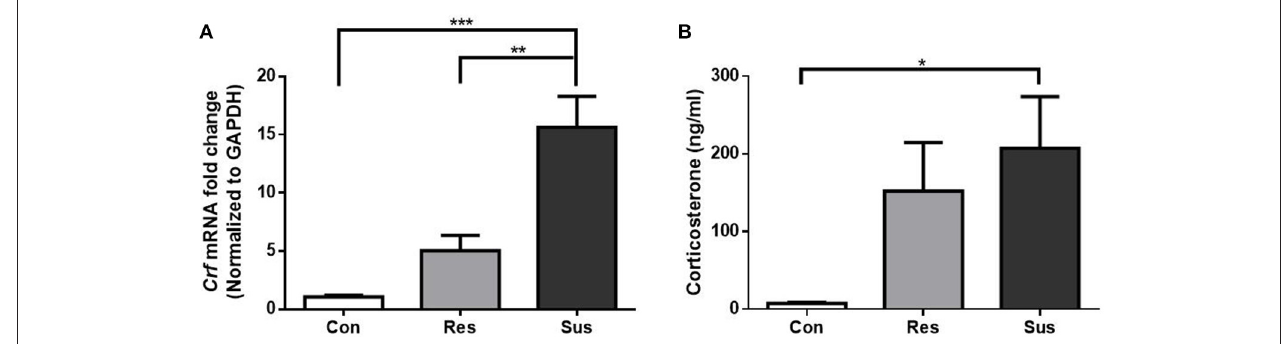
FIGURE 2 | Chronic social defeat stress induced hypercortisolemia in susceptible mice. (A) mRNA expression of Crf in the hypothalamus of mice after exposure to social defeat stress ( n = 6/group). (B) Serum CORT concentration of mice after exposure to social defeat stress ( n = 7/group). All data are shown as mean ± s.e.m. * P < 0.05, ** P < 0.01, *** P < 0.001. Con, Control; Res, Resilient; Sus, Susceptible.